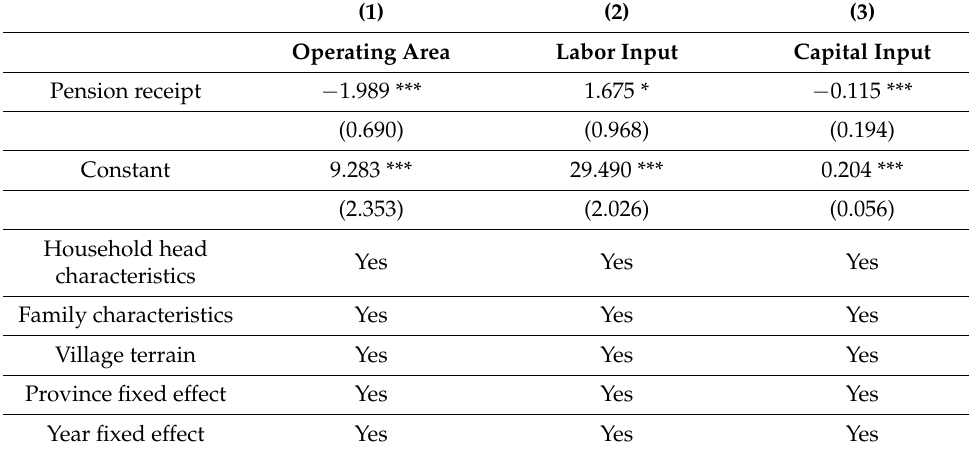
Table 3. IV estimation based on